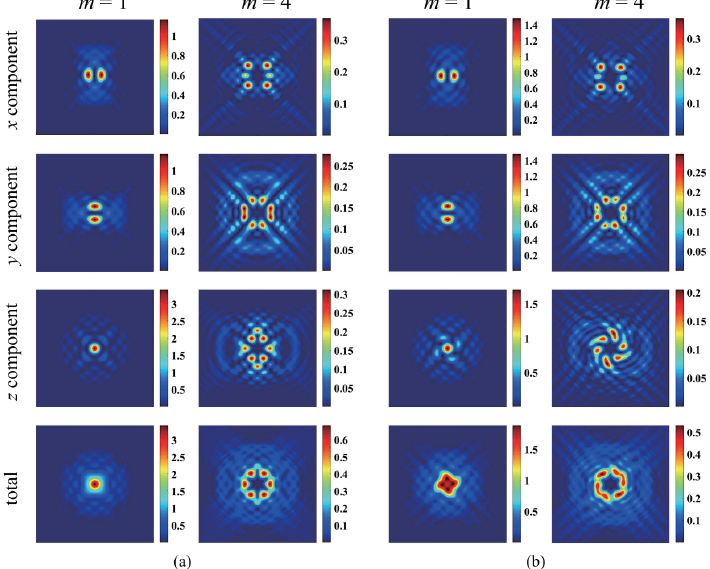
Figure 3. Intensity distributions of the TC (transverse component, x -direction, and y -direction), LC (longitudinal component), and total fi eld of vector optical beams with a twisting phase ( u = 10 13 mm − 2 ) and di ff erent polarization topological charges m in the focal region: ( a ) locally linear polari- zations ( Δ ϕ = 0 in Equation (1)); ( b ) hybrid SOP ( Δ ϕ = π /2 in Equation (1)). Here the size of each plot is 3 λ × 3 λ and the vortex topological charge n = 0.